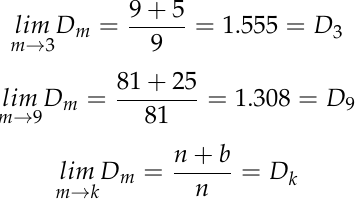
Table 1. Main parameters of GP. Parameter Values Size of organism population 500 Maximum number of generations